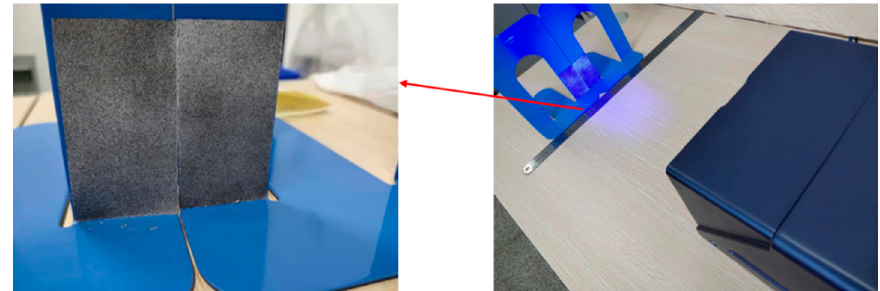
Figure 6. Accuracy verification of single-camera 3D-DIC test system in this study. Table 2. Accuracy verification results of single-camera 3D-DIC test system.